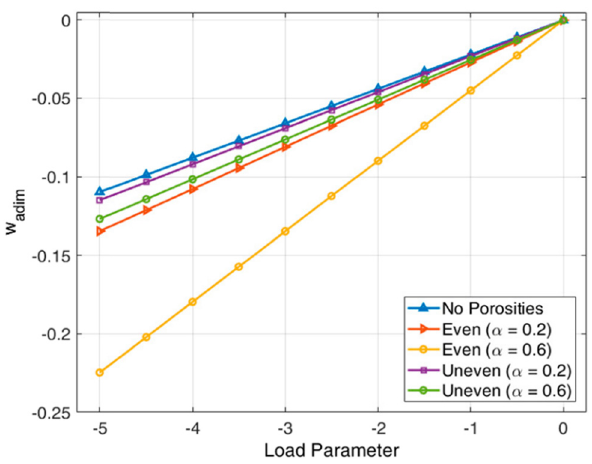
Figure 7: E ff ect of di ff erent porosity distributions and volume frac - tions on the centralized de fl ection [ 28 ]